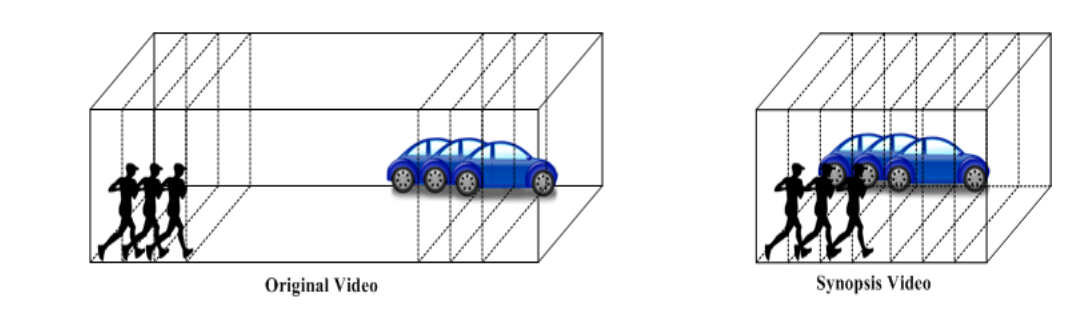
Figure 1. Video synopsis idea.